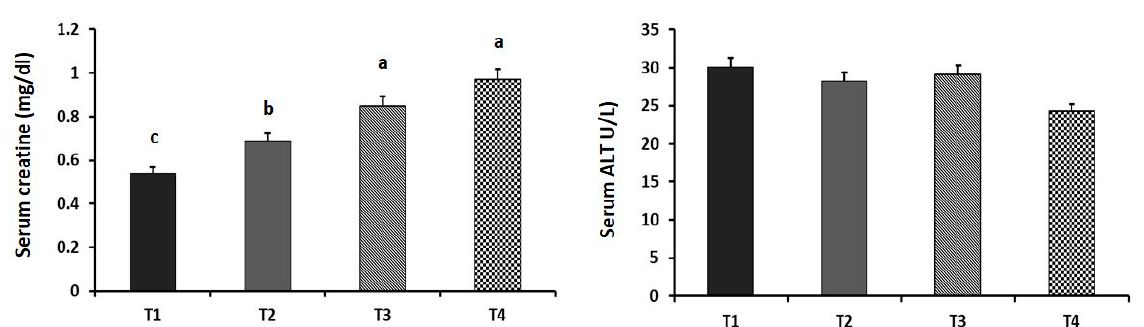
Figure 3. Effect of dietary supplementation of guanidinoacetic acid (GA) on the serum creatine ( p = 0.007, 0.063, and 0.018 as linear, quadratic, and cubic, respectively) and alanine aminotransferase (ALT) levels of aged laying hens ( p = 0.521, 0.090, and 0.658 as linear, quadratic, and cubic, respectively). T 1 = control group; T 2 = group supplemented with 0.5 g GA kg − 1 diet; T 3 = group supplemented with 1 g GA kg − 1 diet; T 4 = group supplemented with 1.5 g GA kg − 1 diet. Means with different letters (a, b, and c) significantly differ at p ˂ 0.05. n = 16 birds/group.